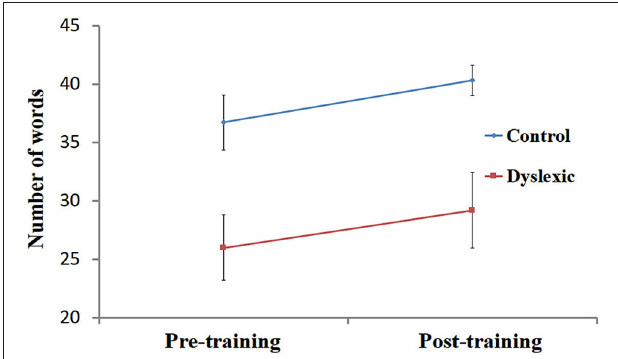
FIGURE 2 | Reading performance pre- and post-training . Number of words read correctly (mean ± SEM) in 30 s, pre- and post-training in the dyslexic (red) and control (blue) groups.